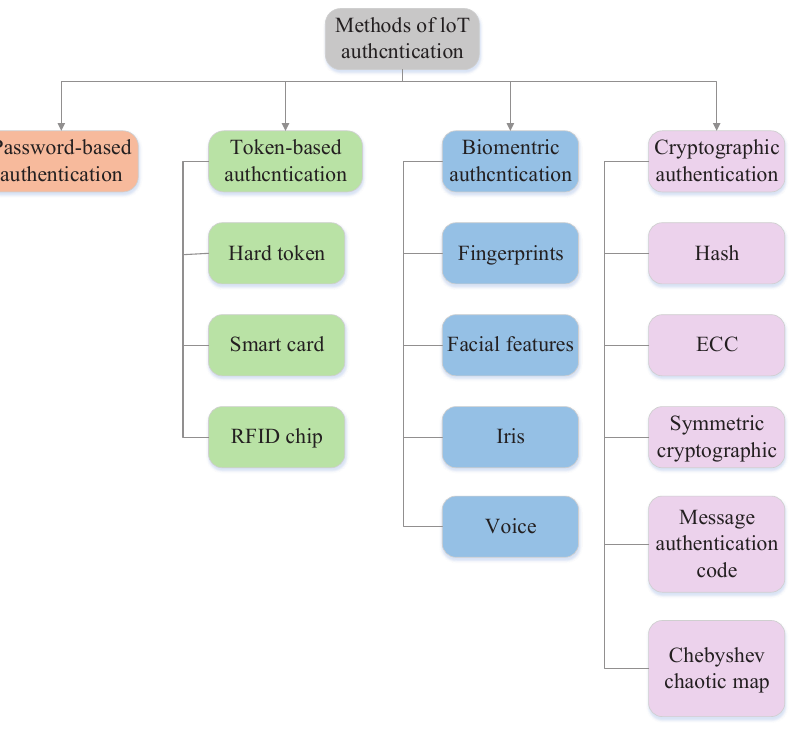
Figure 3. Methods of loT